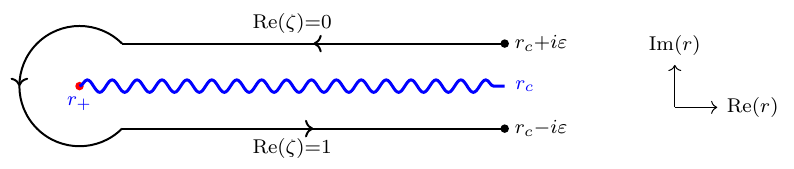
counter- + + iε and ending up at the right boundary c